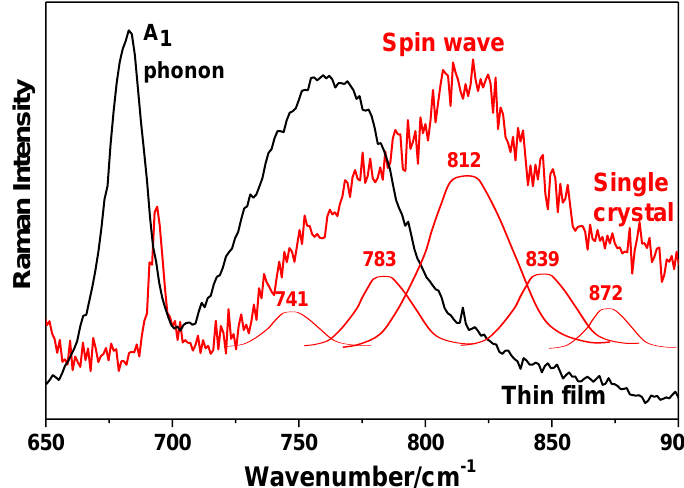
Figure 3. Comparison of spin wave scattering in hexagonal LuMnO 3 single crystal and HoMnO 3 thin film. The spectrum of LuMnO 3 single crystal is from Figure 1 of Ref. [89], the spectrum of HoMnO 3 thin film is from Figure 1 of Ref.